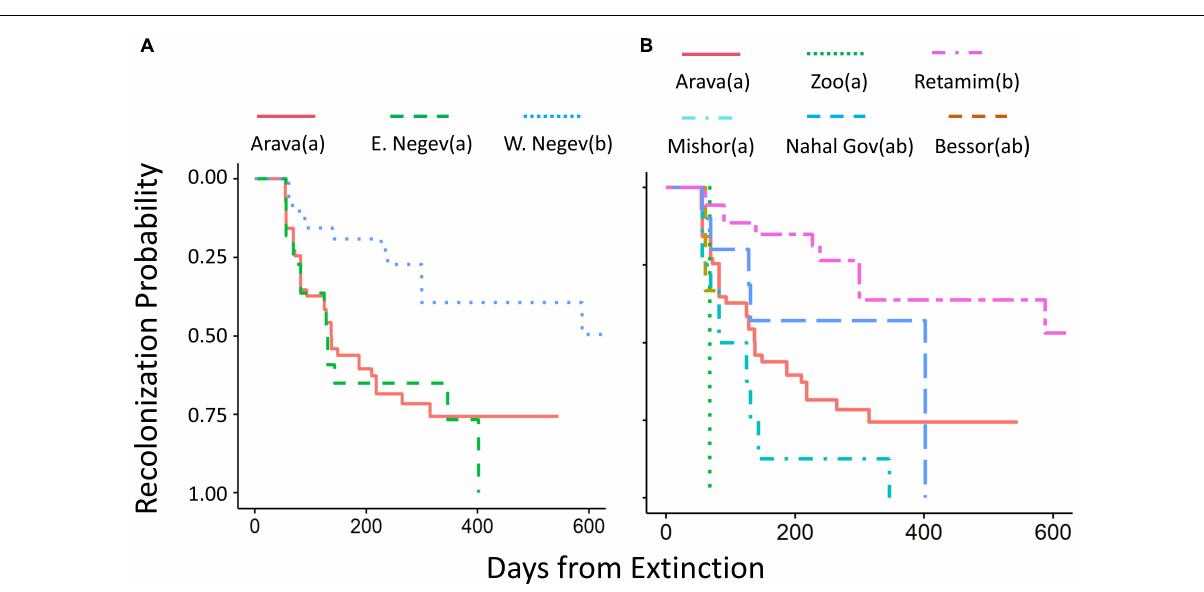
FIGURE 5 | Cumulative recolonization probability by region (A) and site (B) versus the time elapsed (days) from extinction of the previous colony. Significant differences among curves are denoted by different letters in parentheses in the line legend. Pesticide application caused a population collapse at Shuva, and we ended observations at that site before any colonies went